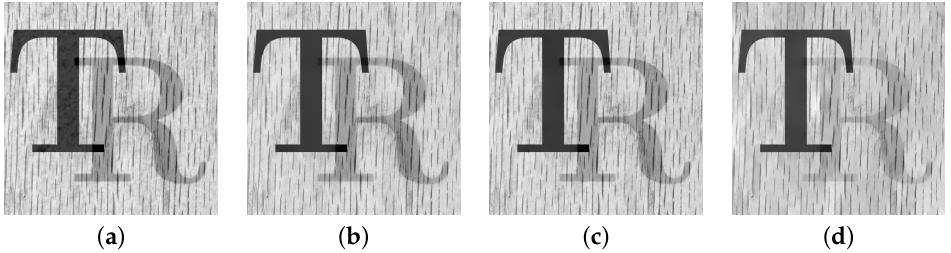
Figure 1. Comparison using a toy example. ( a ) The input test image. ( b ) The result of algorithm [2]. ( c ) The result of algorithm [3]. ( d ) The result of proposed algorithm with N = 4.